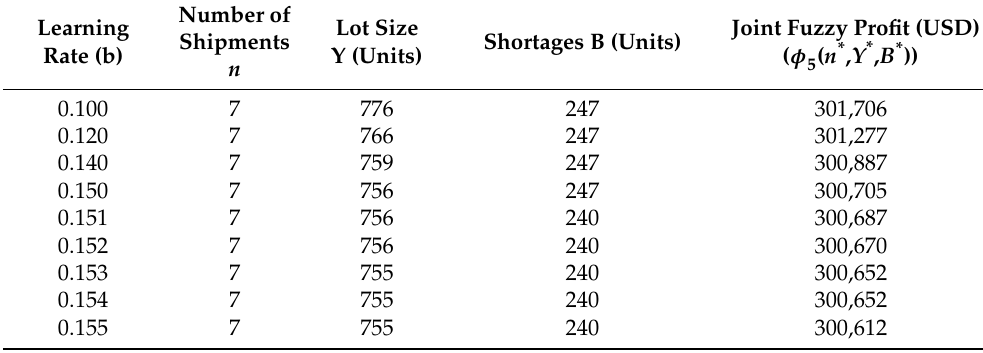
Table 4. Impact of the learning rate on the decision variable and joint total fuzzy